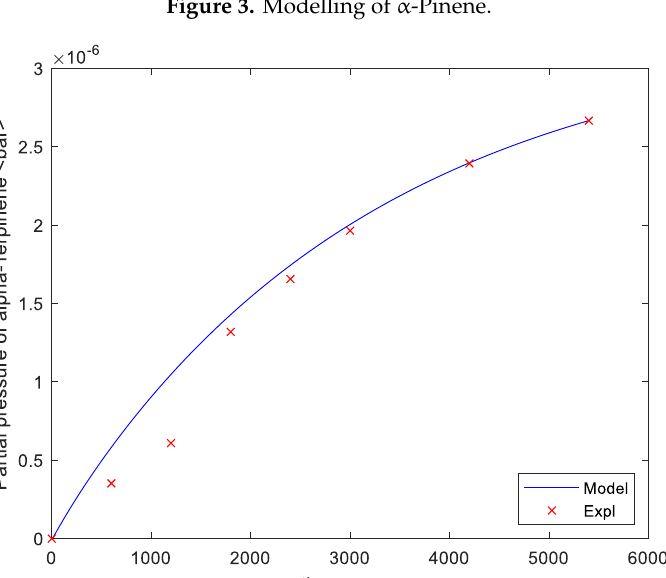
Figure 3. Modelling of α-Pinene.